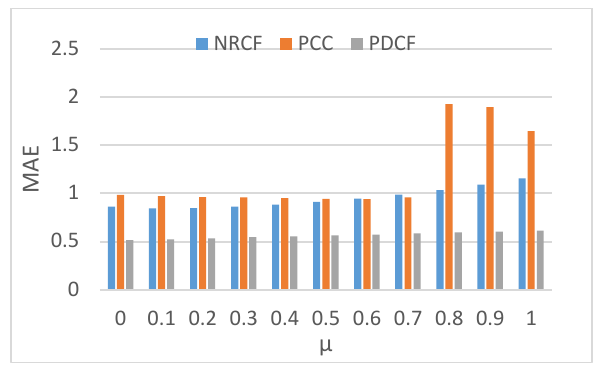
Figure 5. Best value of c based on different values of density.